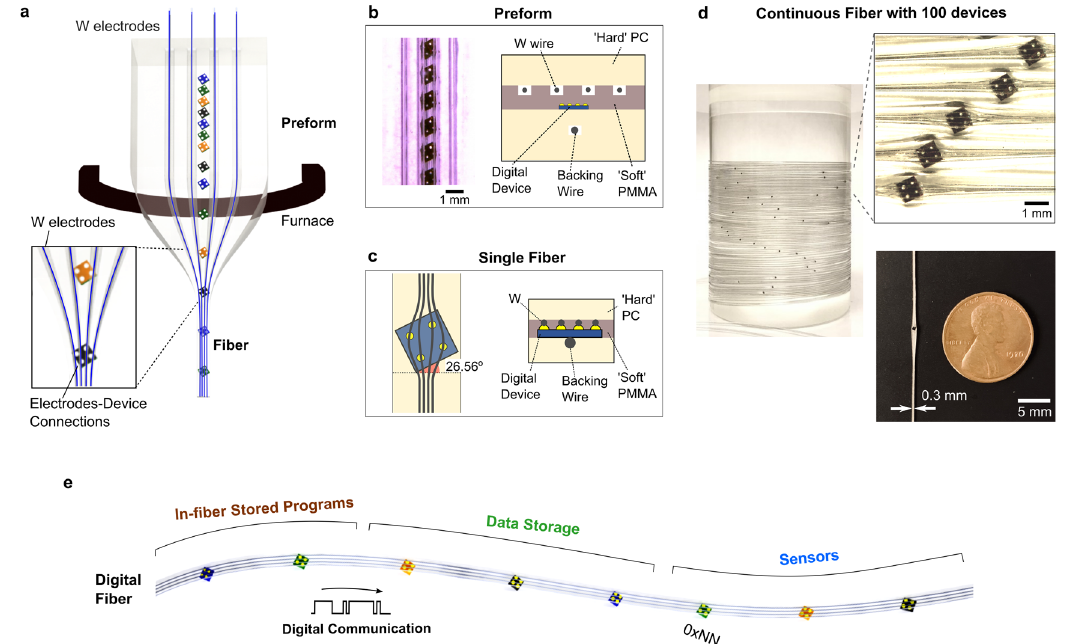
Fig. 1 Fabrication approach of digital fi bres. a Thermal drawing of the digital fi bre preform by feeding conductive tungsten wires into the empty channels. At the preform level, the tungsten (W) wires are spaced far apart with a polymeric barrier separating the device and the wires. The inset shows the converging of the four tungsten (W) electrodes toward the four electrical device pads at the necking region of the preform-to- fi bre transition. b (left) Optical micrograph of the rotated devices embedded within preform slots milled at a critical angle of 26.56° relative to the preform axis. (right) Cross- sectional schematic of preform, containing three layers (hard PC/soft PMMA/hard PC). The presence of the hard PC enables an inwards compression that allows W electrodes to break through the soft PMMA barrier and make contact with the device electrical pads. The backing wire is used to compress the device on the opposite side from the electrode wires and to prevent tilting of the device along the fi bre length. c (left) Schematic of drawn fi bre with the rotation of embedded devices preserved at the critical angle of 26.56°, allowing for the electrical pads to contact four parallel wires without shorting. Spreading of the tungsten wires at the device region is also taken into account for the wires to align with these electrical pads. (right) Cross section schematic of the digital fi bre at the device region, showing electrical contacts between device and wires. d (left) Photograph of a spool containing a continuous digital fi bre with 100 embedded devices. (right) Magni fi ed optical image of the fi bre array showing that the digital devices are all rotated to the critical angle with connections to wire electrodes. (bottom) Photograph showing size comparison between the fi bre and a coin (penny). e Illustration of the thermally drawn digital fi bre encapsulating chips of different functionalities such as memory or sensing. Each of the chips is represented by a unique and different digital address in hexadecimal format (0xNN). The four wires within the fi bre serve different functions: signal line for exchanging data between in- fi bre devices, clock line to regulate communications signal timing, ground line, and power